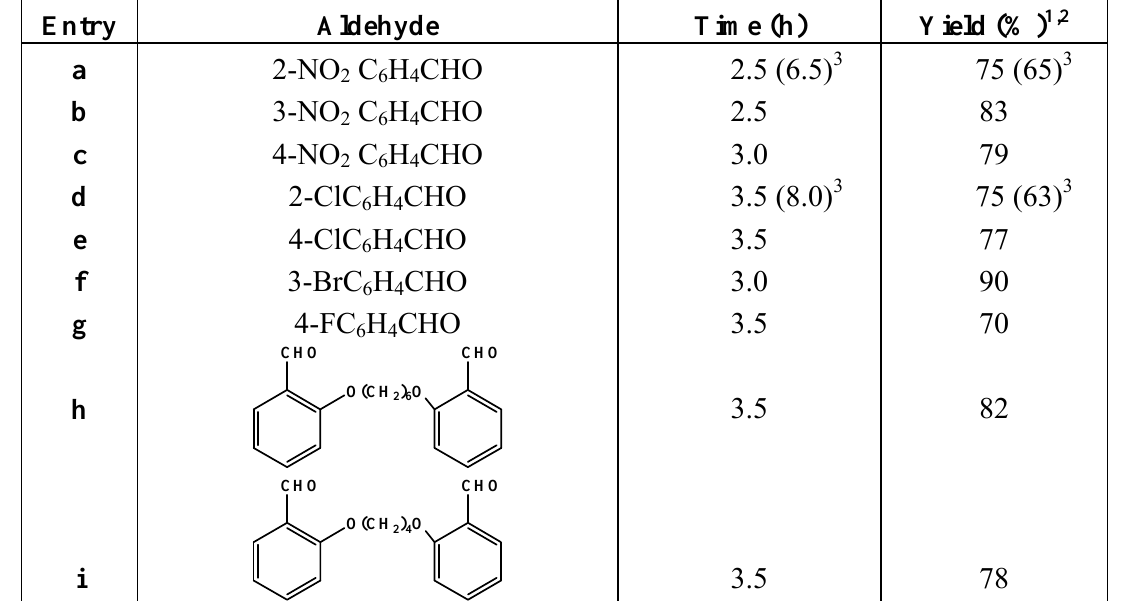
Table 1. Synthesis of fused 1,4-dihydropyridine derivatives ( 3a-i ) using